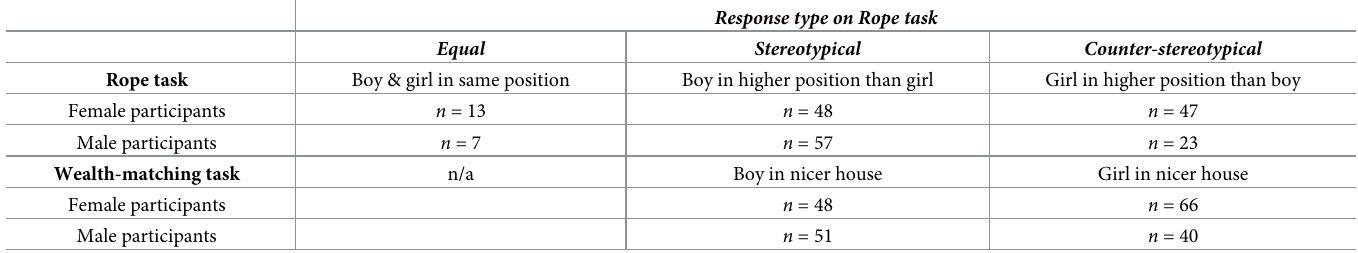
Table 1. Number of Study 1 participants who provided a given response type for the rope task and wealth-matching task, separately for male and female partici- pants. Table includes only participants whose parents reported child gender ( n =